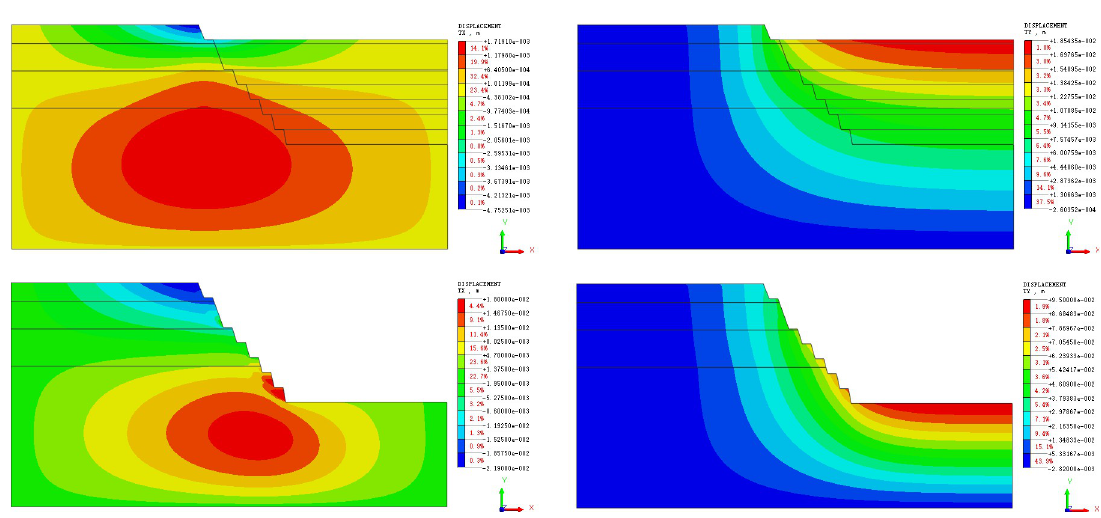
Fig 10. (a). Horizontal displacement cloud map of step 1. (b). Horizontal displacement cloud map after excavation. (c). Vertical displacement cloud map of step 1. (d). Vertical displacement cloud map after excavation.